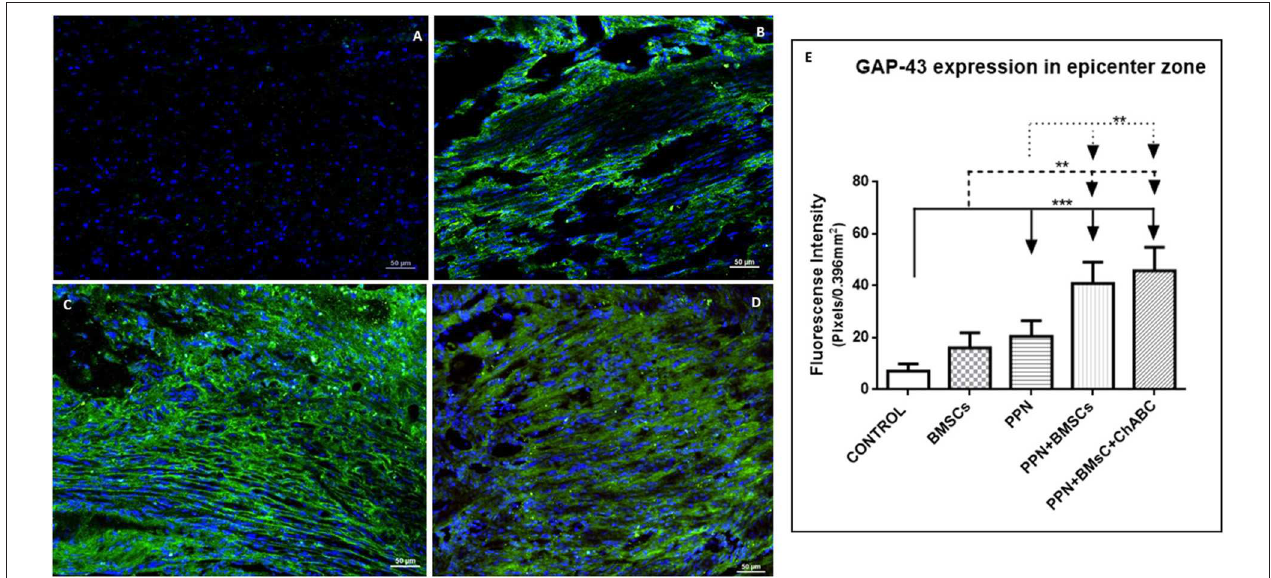
FIGURE 2 | Expression of GAP-43 at the epicenter. (A–D) Show representative images of immunoreactive fibers for GAP-43 (green) of groups control (A) , PPN (B) , PPN + BMSCs (C) , and PPN + BMSCs + ChABC (D) . Note that fibers in the PPN group seem disordered, scarcer, and thinner compared to combined groups. Scale bar (A–C) = 50 µ m. Plots in (E) show quantification of fluorescein density at the epicenter zone. Data are expressed as the mean ± S.D. ( n = 6). Statistical analysis: Kruskal Wallis followed by U -Mann Witney. *** p < 0.0001; ** p < 0.05.